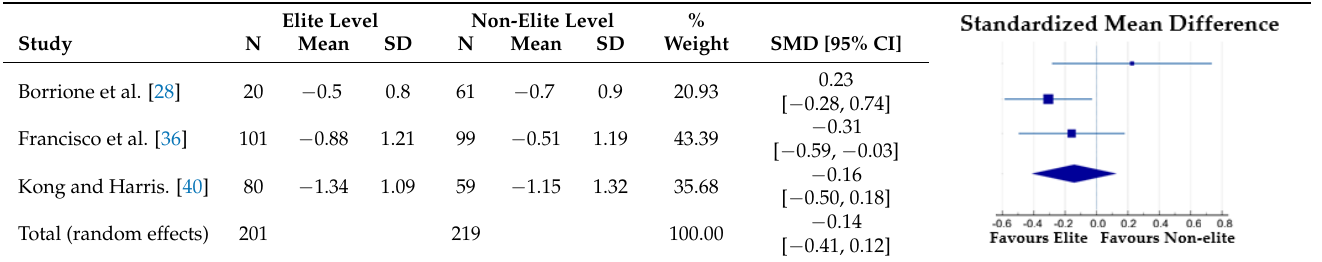
Table 4. BID by the level of sports in female athletes.